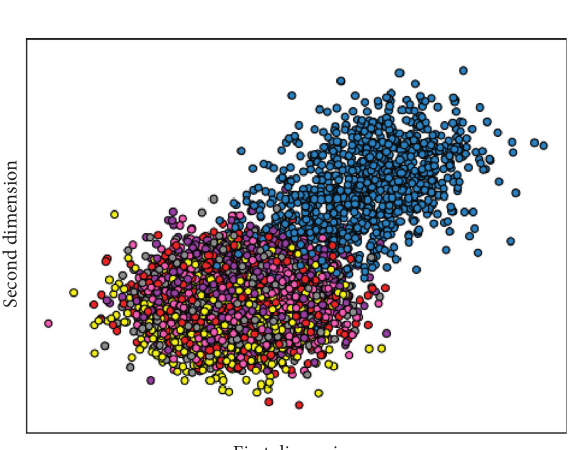
Figure 3: Two-dimensional scatter plot of original data.